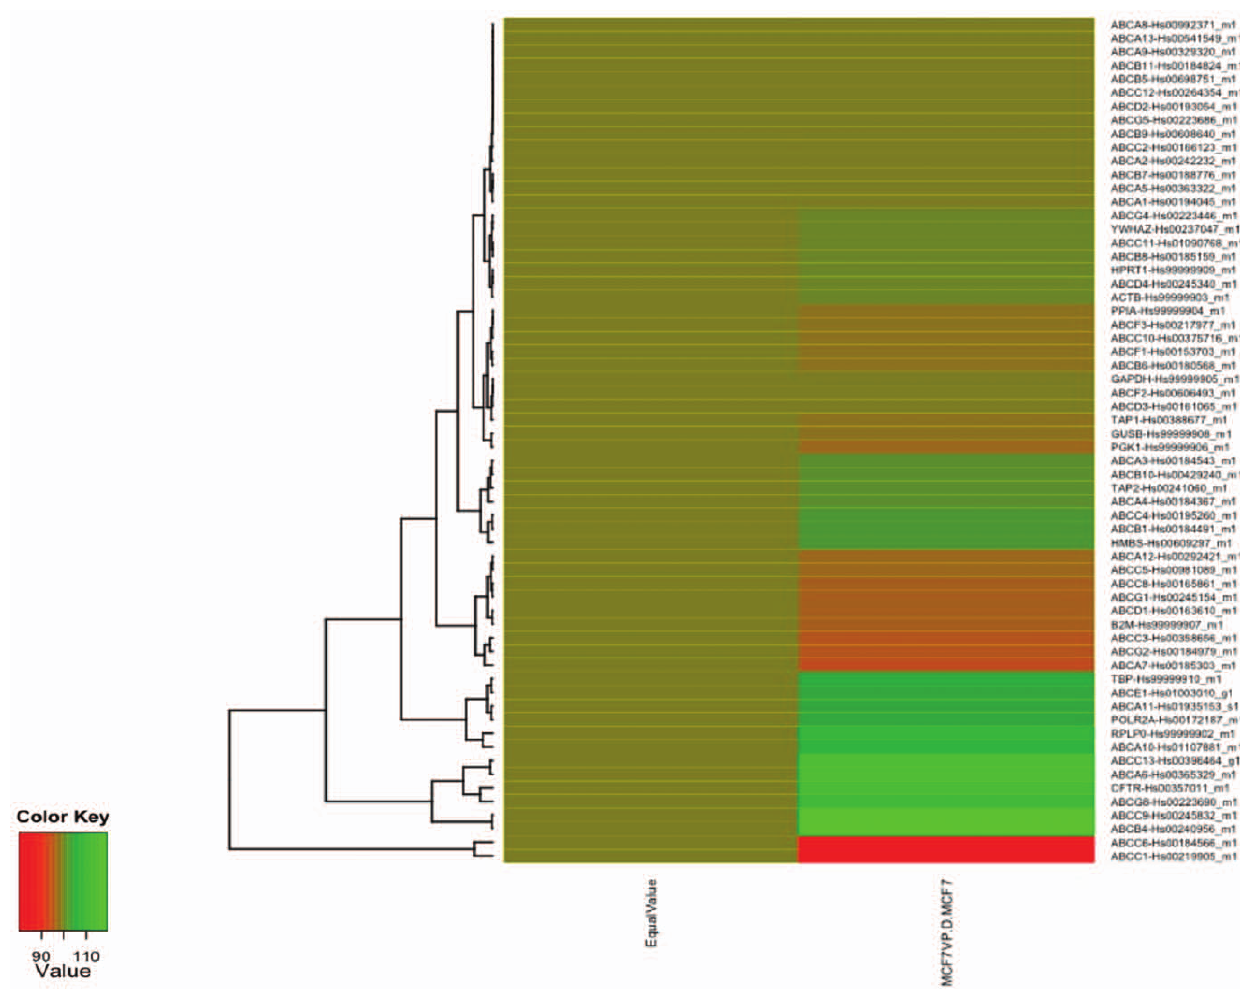
Figure 2. Heat map depicting the upregulation of ABCC6 and ABCC1 genes in MCF7VP cells. It can be seen that both ABCC6 (red) and ABCC1 (red) genes are upregulated in the MCF7VP cell lines. cDNA from the MCF7 and MCF7VP cells was used to run the Taqman Low Density ABC transporter arrays. The data was analyzed using Microsoft excel and R-Bioconductor to generate heat maps of the ABC array data.